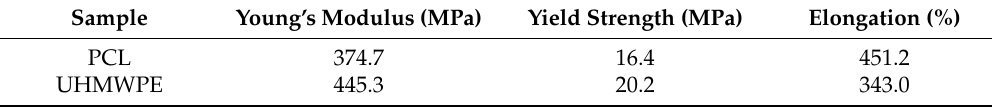
Table 4. Mechanical properties of PCL and UHMWPE from uniaxial tensile